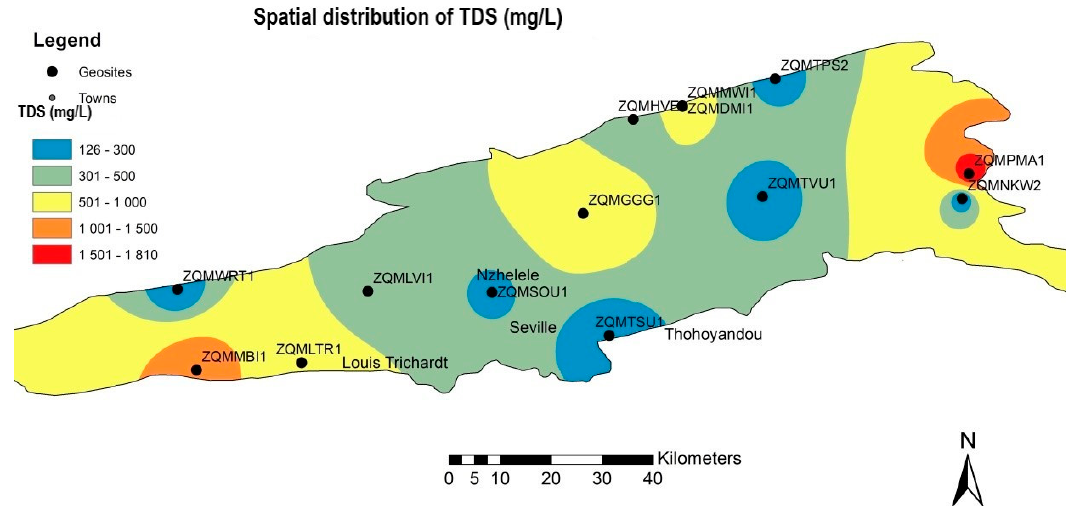
Figure 3. Spatial distribution of TDS in the Soutpansberg region.